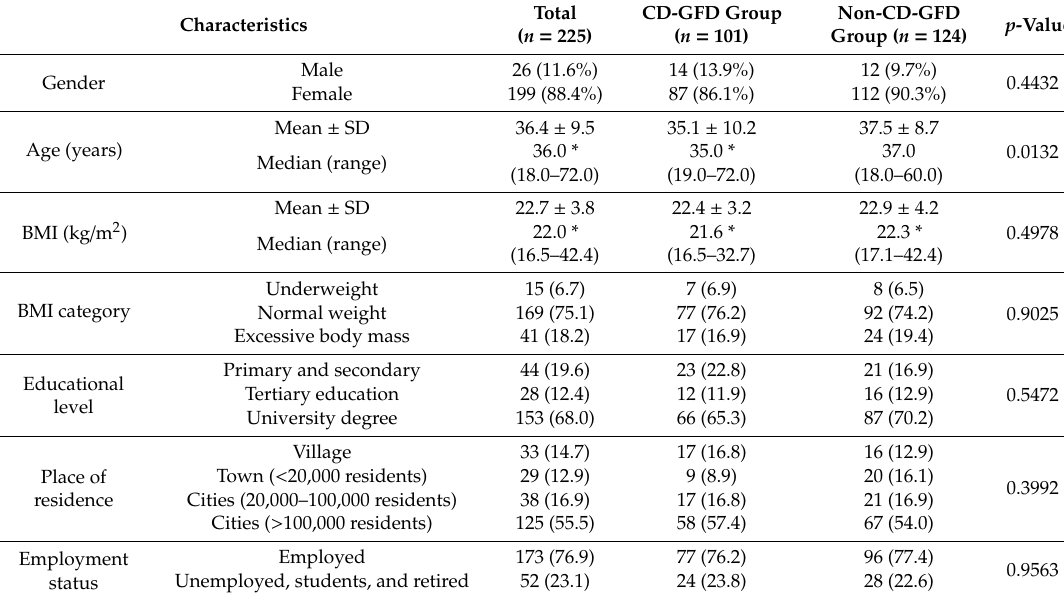
Table 1. Characteristics of the study subjects.